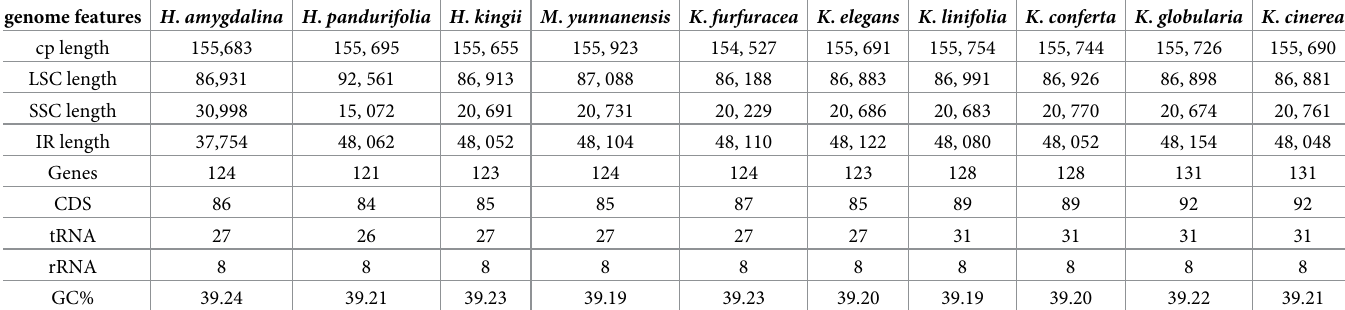
Table 2. Summary of features of ten species of Myristicaceae. genome features H . amygdalina H . pandurifolia H . kingii M . yunnanensis K . furfuracea K . elegans K . linifolia K . conferta K . globularia K .